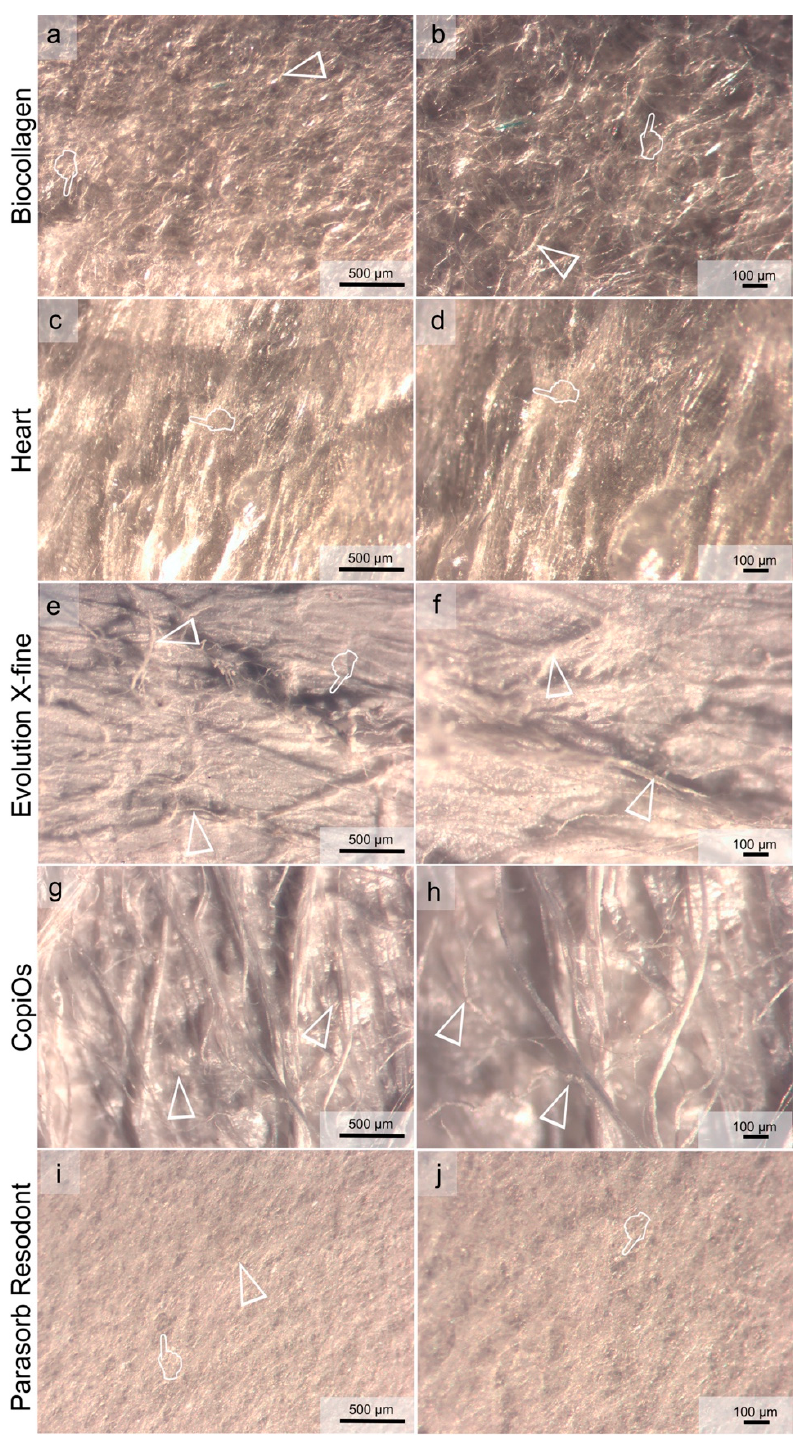
Figure 4. Light micrographs taken of the rough surface of the membranes before immersion. ( a ) Biocollagen surface at 60× magnification. ( b ) Biocollagen at 120× magnification. ( c ) Heart surface at 60× magnification. ( d ) Heart surface at 120× magnification. ( e ) Evolution X-fine surface at 60× magnification. ( f ) Evolution X-fine surface at 120× magnification. ( g ) CopiOs surface at 60× magnification. ( h ) CopiOs surface at 120× magnification. ( i ) Parasorb Resodont surface at 60× magnification. ( j ) Parasorb Resodont surface at 120× magnification. In ( a , c , e , g , i ), the scale bar is 500 μ m, it is and 100 μ m in ( b , d , f , h , j ). Pointers indicate pores of different size across the membrane’s surface. Arrow heads indicate collagen fibers. Arrows point to mineral deposits on the membrane´s surface.